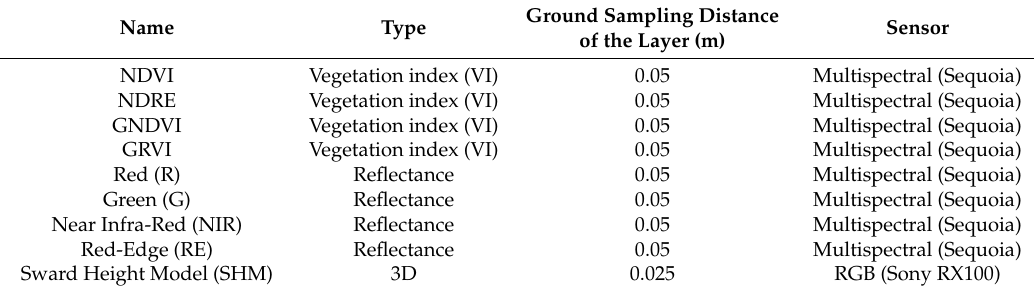
Table 2. Variables extracted from the UAS